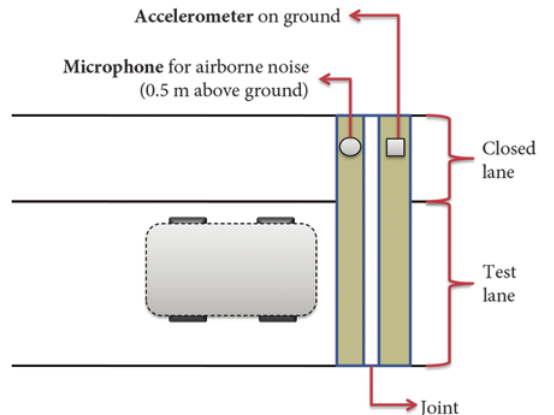
Fig. 2. Schematic setup of Direct Sound and Vibration Measurement Methodology